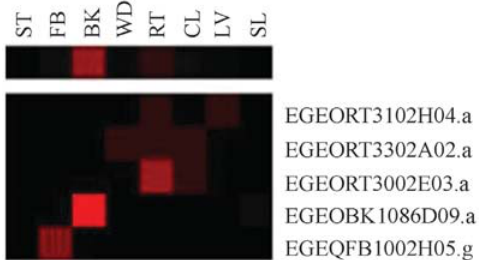
Figure 4 - Hypothetical expression pattern of sequences similar to BOR1 found in FORESTs database, evaluated with normalized data. Each EST contig is represented in a line and each tissue with sequenced cDNAs in a column. Black means no expression, and different intensity red means the expression intensity of each read in a tissue. Legend: ST - stem; FB - flower bud; BK - bark, xylem, heartwood and medulla; WD - wood; RT - root; CL - callus; LV - leaves; SL - seedlings.